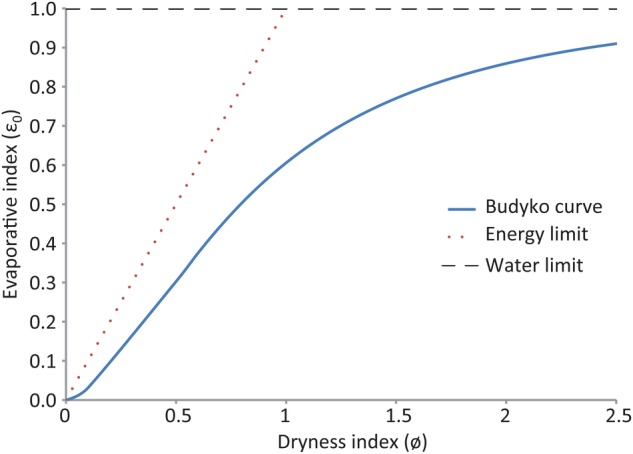
The Budyko curve for the relationship between the long-term dryness index and the evaporative index and the energy and water limits to long-term evaporation.